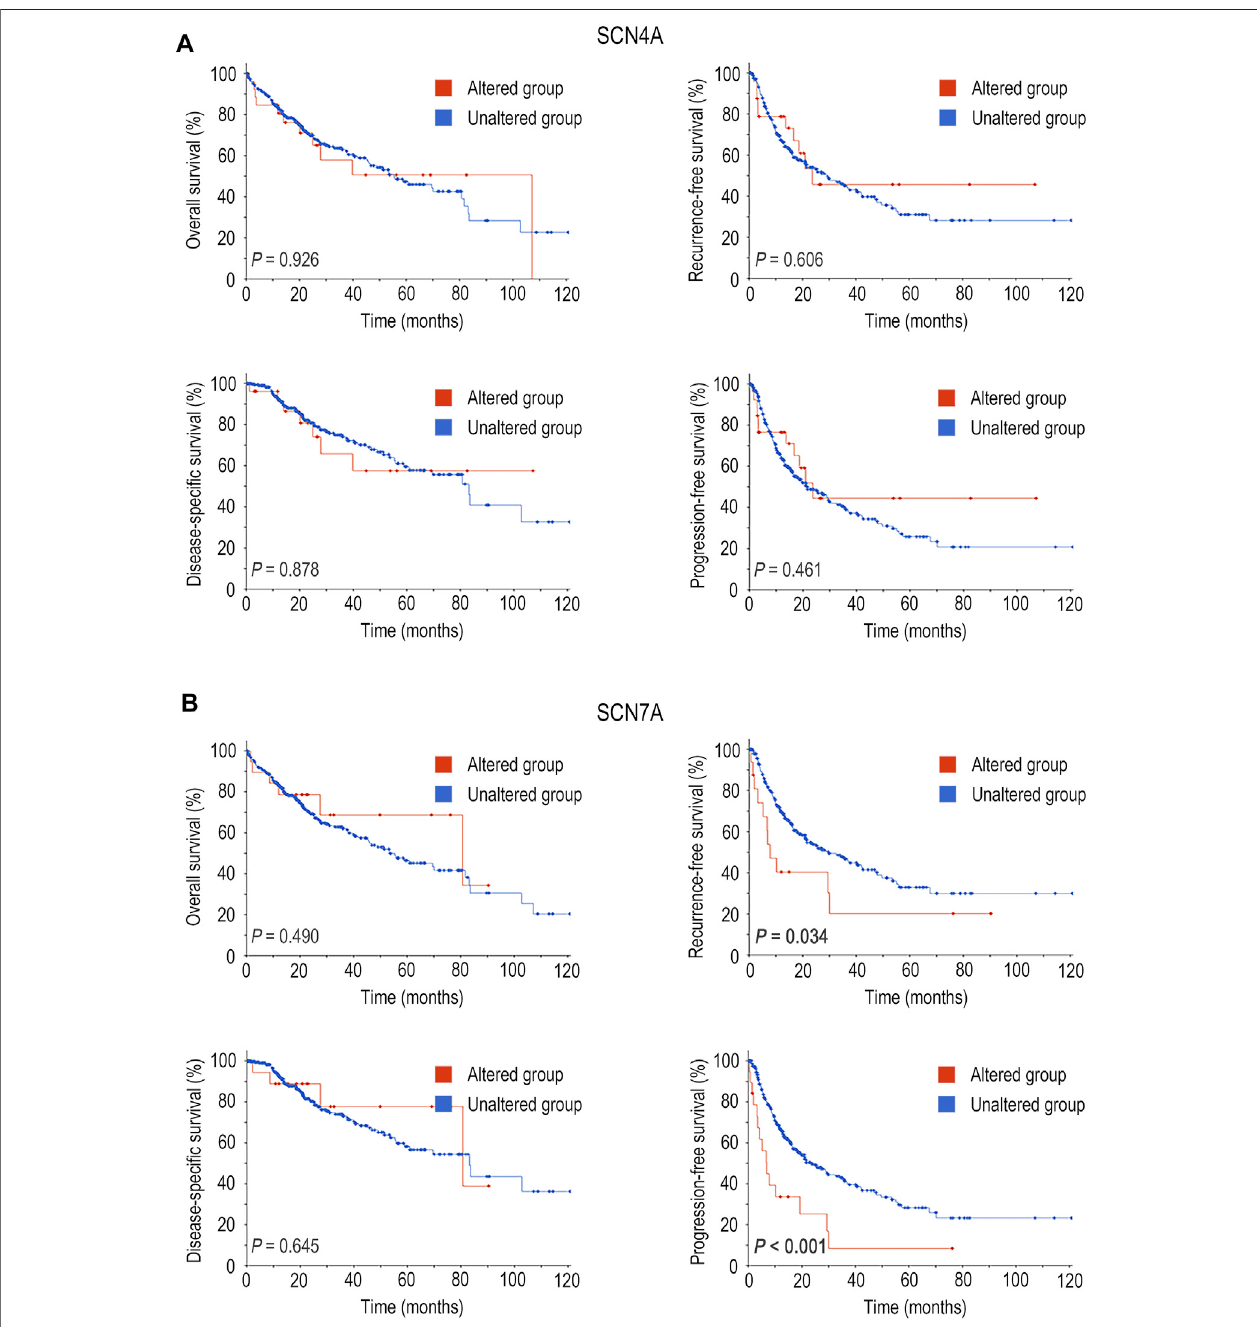
FIGURE4| SurvivalanalysisofSCN4A/7AmutationsinHCCbycBioPortal. (A) SCN4A mutationwasnotrelatedtoOS( p > 0.05),RFS( p > 0.05),DSS( p > 0.05)or PFS ( p > 0.05). (B) SCN7A alteration was related to RFS ( p (cid:1) 0.034) and PFS ( p < 0.001).